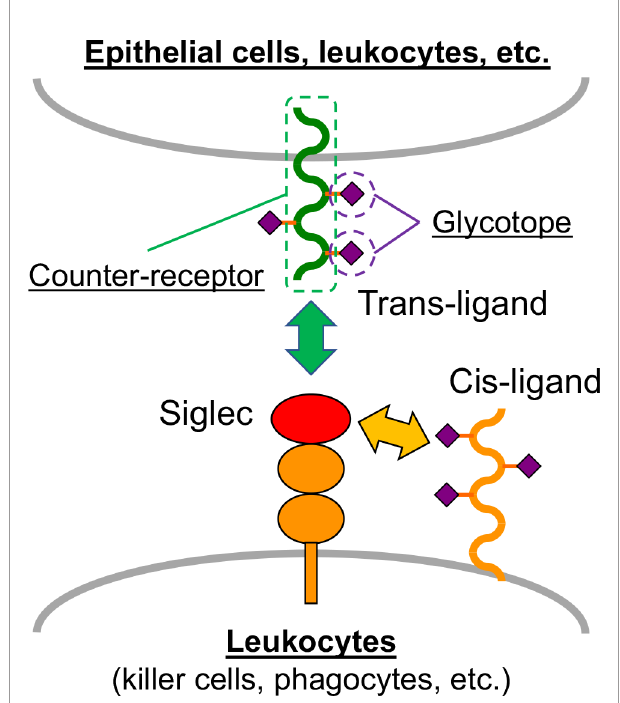
FIGURE 1 | Siglec and Siglec ligand. Most Siglecs are expressed on leukocytes. The ligands on the same cell that express Siglec are called cis- ligands, and those on the juxtaposing cells (e.g., epithelial cells and other leukocytes) are called trans-ligands. Glycoprotein ligands of Siglecs comprise two constituents: glycotope, which directly interacts with Siglec, and counter- receptor, which is the protein backbone that displays the